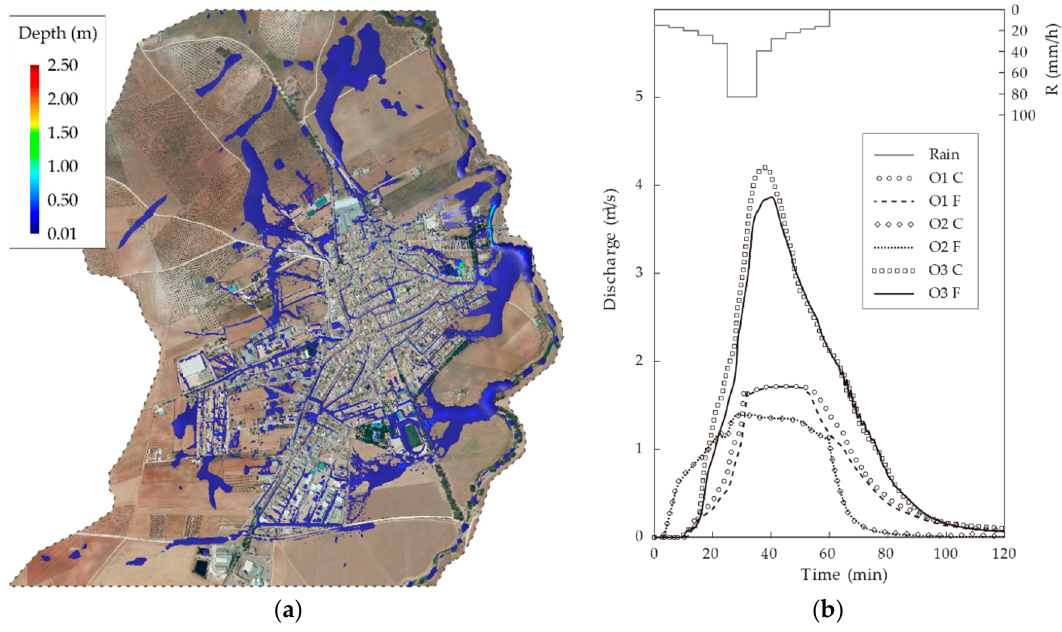
Figure 12. ( a ) Maximum depths at surface; ( b ) numerical hydrographs computed at outfalls for a 1 h design storm with a 25-year return period for coarse (C) and fine (F) mesh .